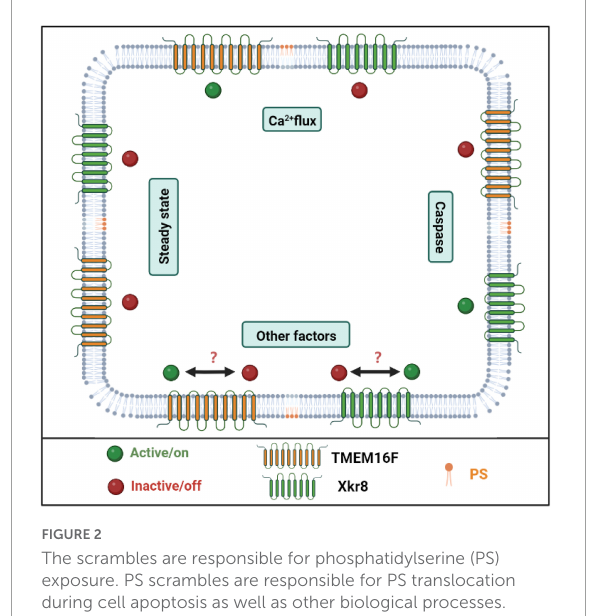
FIGURE2 The scrambles are responsible for phosphatidylserine (PS) exposure. PS scrambles are responsible for PS translocation during cell apoptosis as well as other biological processes. TMEM16F and XKr8 are well-documented PS scrambles. When the intercellular Ca 2 + concentration is upregulated, TMEM16F binds Ca 2 + and transports PS to the outer leaflet of the plasma membrane. When the cell undergoes apoptosis, caspase cleaves and activates XKr8, and then XKr8 exposes PS to the outside of the cell and releases the “eat me” signal. But in other biological processes, it remains unknown which scramble is activated or both of them are activated. Created with BioRender.com.